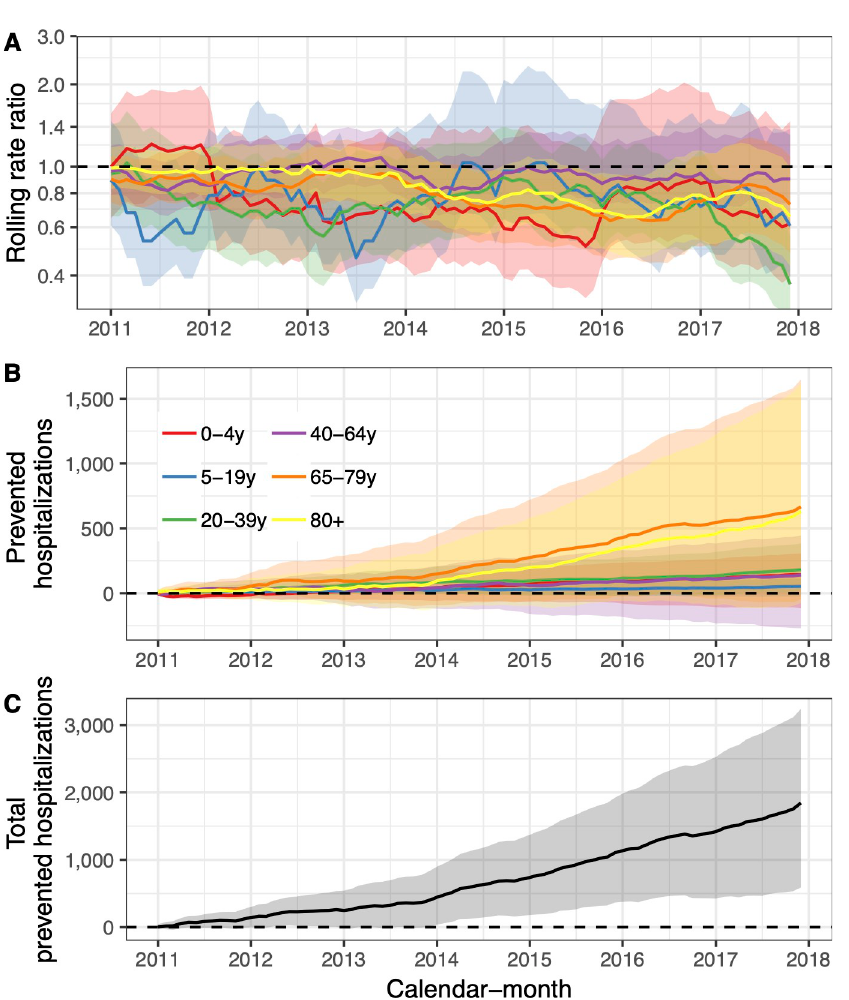
Fig 4. The population impact of the vaccine (PHiD-CV10) on pneumonia hospitalisations is summarized. In Panel A, the estimated 12-month rolling rate ratio between observed and predicted pneumonia hospitalisations is shown per age-group, and the 95% credible intervals (CI) are illustrated as a shaded areas. Panel B depicts the cumulative number of prevented pneumonia hospitalisations during the post-vaccine period (2011–2017) for each age-group along with 95% CI. The total cumulative prevented pneumonia hospitalisations regardless of age-group is shown in Panel C.